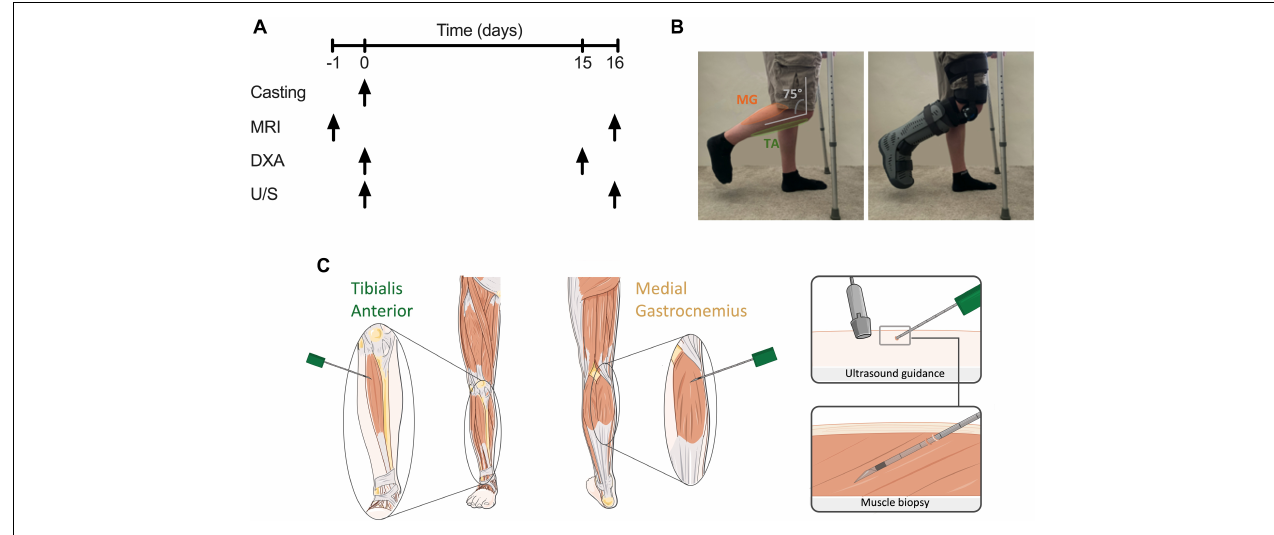
FIGURE 1 | (A) Schematic diagram of study protocol; (B) unilateral lower leg immobilisation using knee brace and foot boot; (C) representative image of microneedle muscle biopsies of tibialis anterior (TA) and medial gastrocnemius (MG) under ultrasound